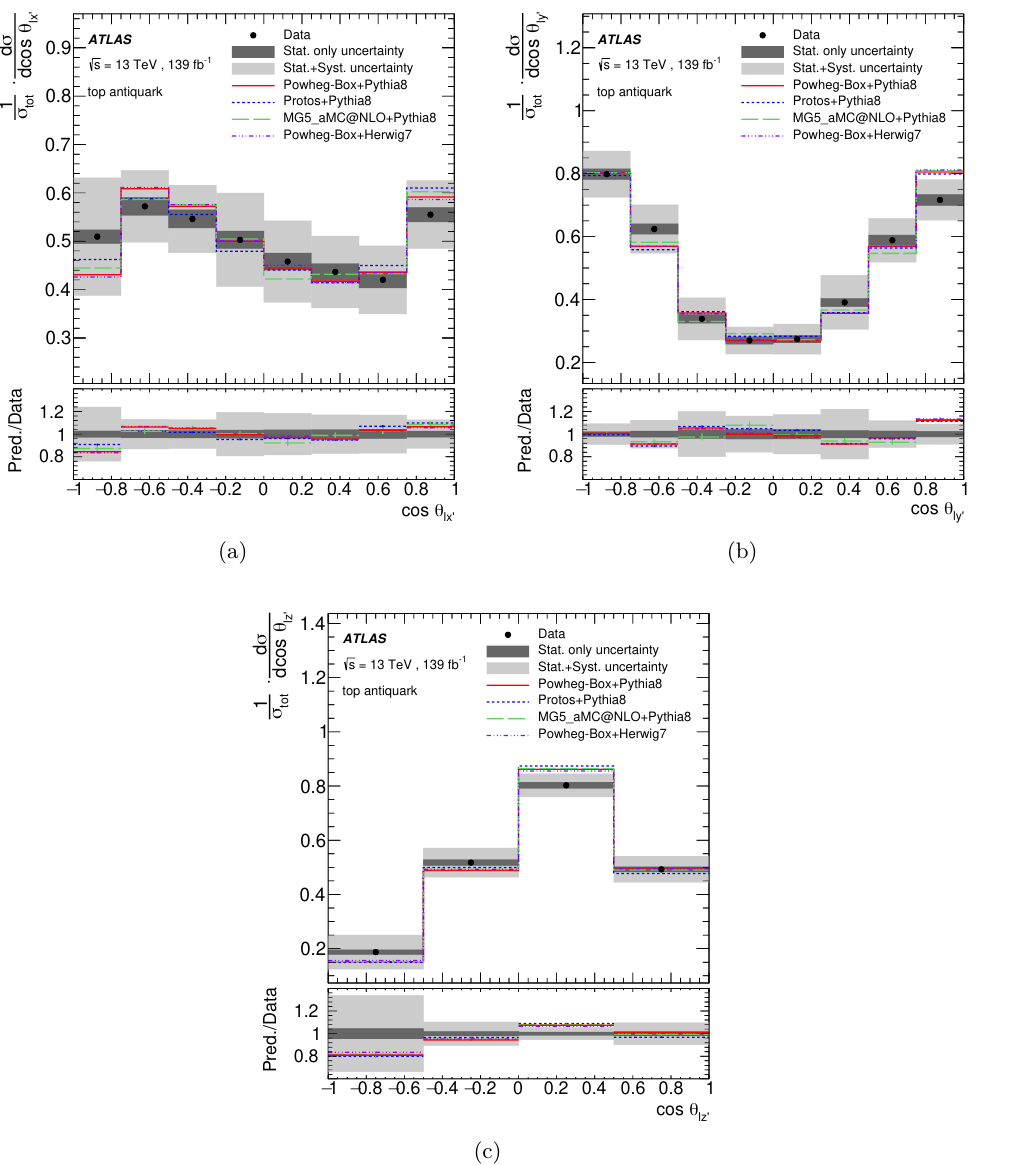
Figure 9 . Particle-level normalised differential cross-sections as a function of (a) cos θ ‘x 0 , (b) cos θ , and (c) cos θ , along with various SM MC predictions of the t -channel signal for top anti- ‘y 0 ‘z 0 quarks. The data, shown as the black points with statistical uncertainties, are compared with predic- tions (lines) obtained by using the Powheg Box + Pythia 8 (solid red), Protos + Pythia 8 (dashed blue), MadGraph5_aMC@NLO+Pythia 8 (long-dashed green) and Powheg Box + Herwig 7 (dot-dashed violet) generators. The uncertainty bands include both the statistical and systematic uncertainties. The data statistical uncertainty is too small to be visible. The lower panels show the ratio of prediction to data in each